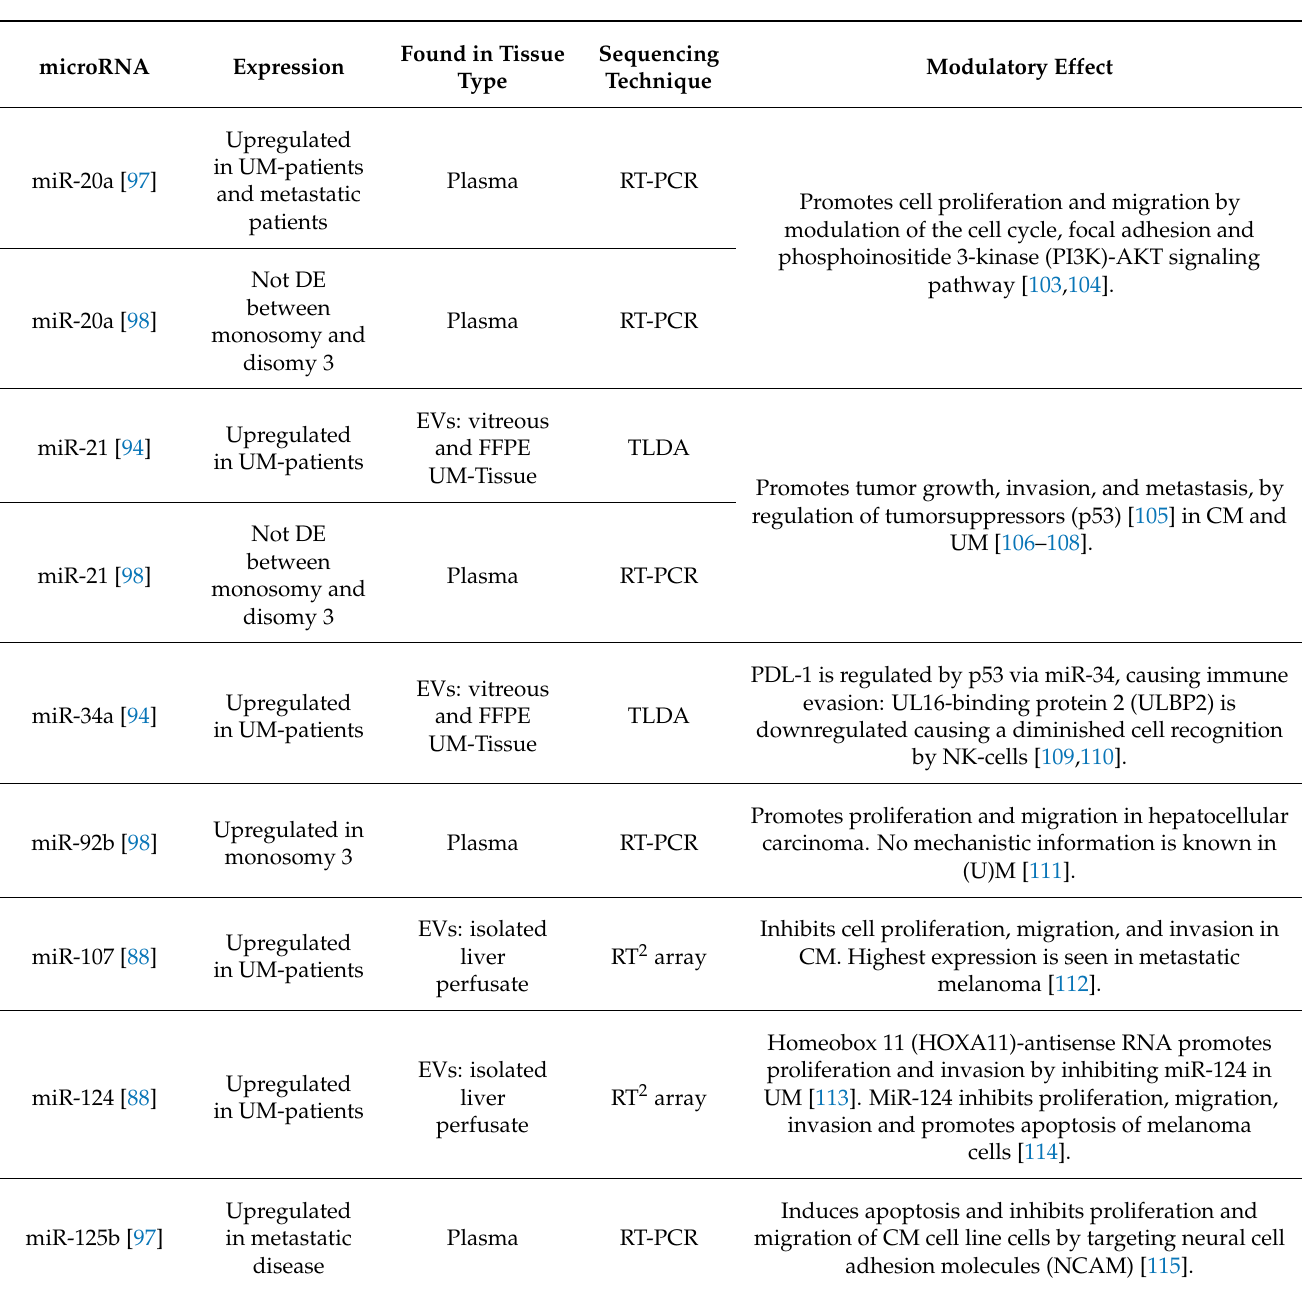
Table 2. Regulatory effects in cutaneous or uveal melanoma of upregulated microRNA found in plasma and extracellular vesicles in vitreous humor, peripheral blood, blood collected during iso- lated liver perfusion, and/or UM-tissue. Expression compared to: UM-patients versus healthy controls; Metastatic patients versus localized disease; Monosomy 3 versus disomy 3. Abbrevia- tions: DE: differentially expressed; RT-PCR: reverse transcription polymerase chain reaction; EVs: extracellular vesicles; TLDA: Taqman low density array; RT 2 array: Qiagen RT 2 miRNA PCR array (brain cancer panel); qNPA: HTG molecular diagnostics quantitative nuclease protection assay;